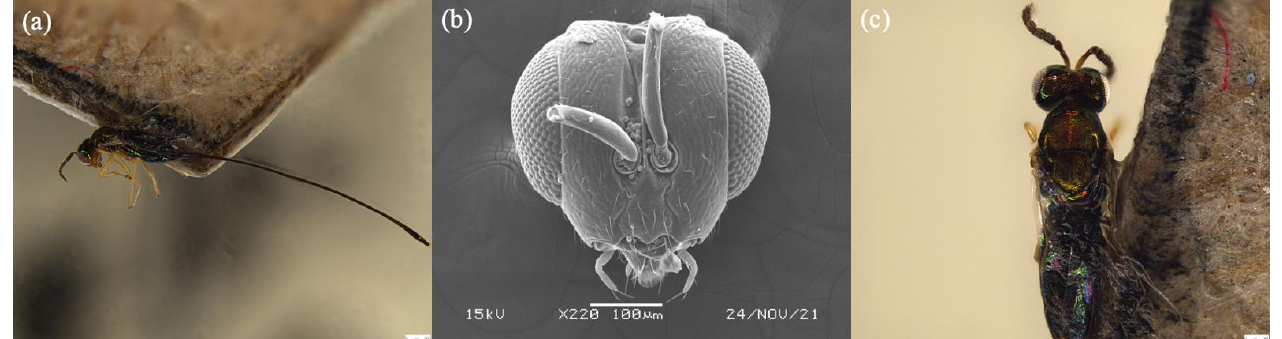
Figure 4. Sycoryctes javaensis sp. n. in ( a ) habitus lateral view; ( b ) head dorsal view; and ( c ) mesosoma dorsal view. Scale bars on the stacked images are 250 μm.